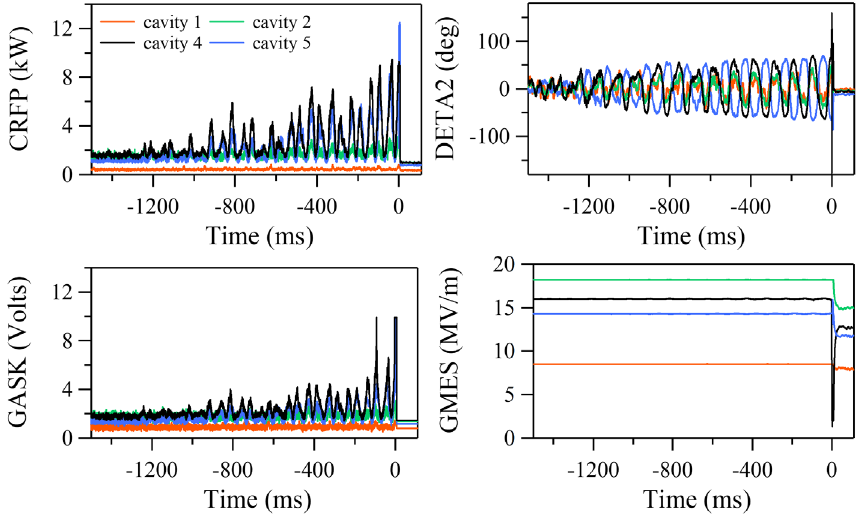
FIG. 5. Waveforms for a microphonics-induced fault. The plots display the forward power (top left), detune phase angle (top right), a digital signal proportional to the drive voltage (bottom left), and the measured gradient (bottom right). (Only four of the eight cavities are plotted for